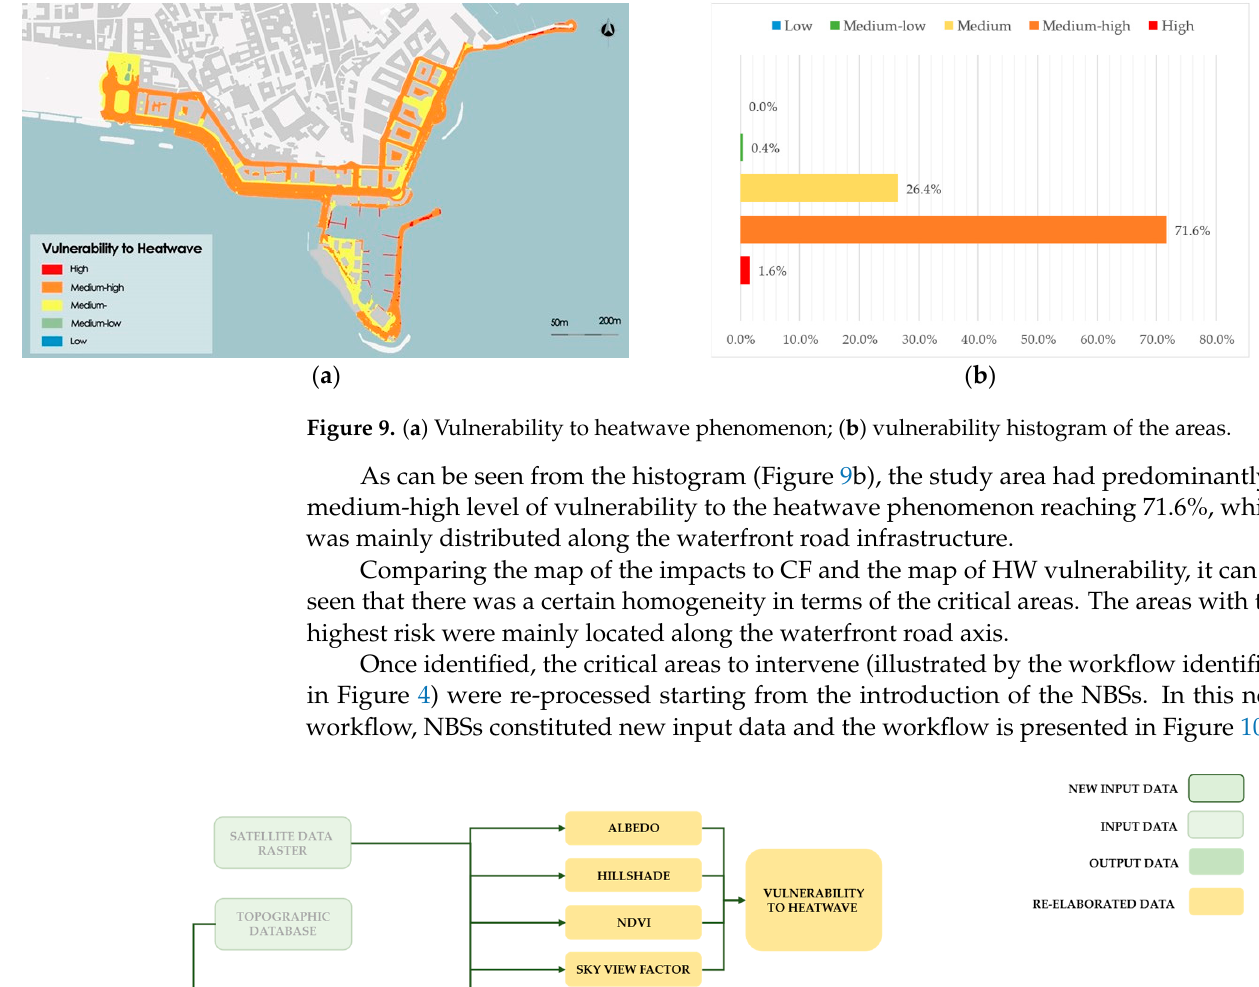
Figure 8. ( a ) Map of Albedo; ( b ) map of Hillshade; ( c ) map of NDVI; ( d ) map of Sky View Factor.